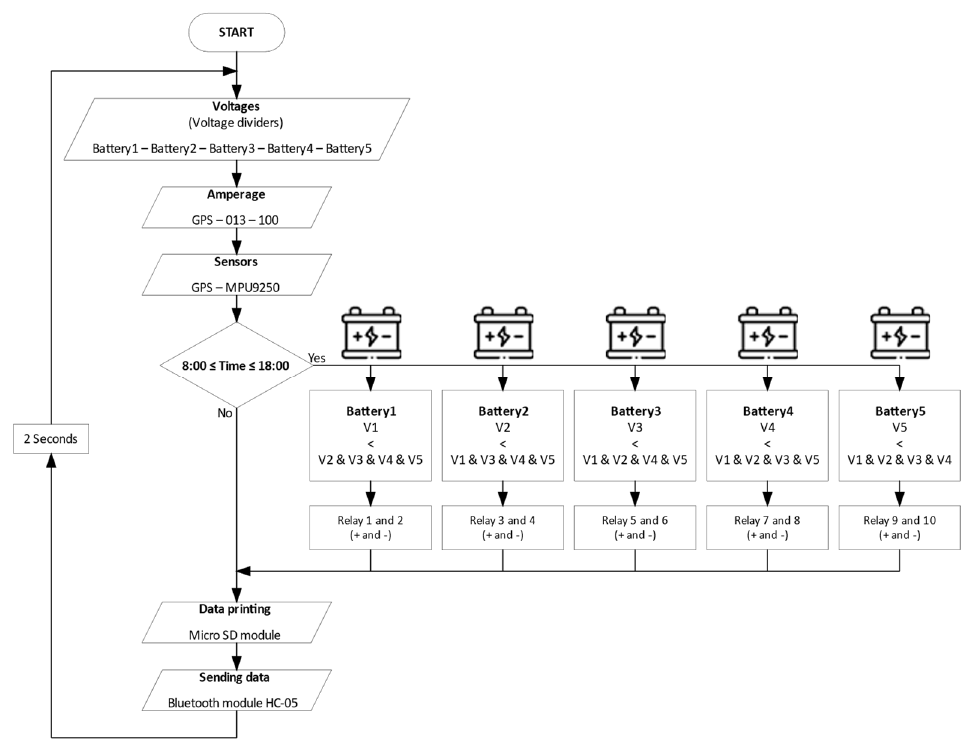
Figure 3. Flowchart showing data collection and storage.